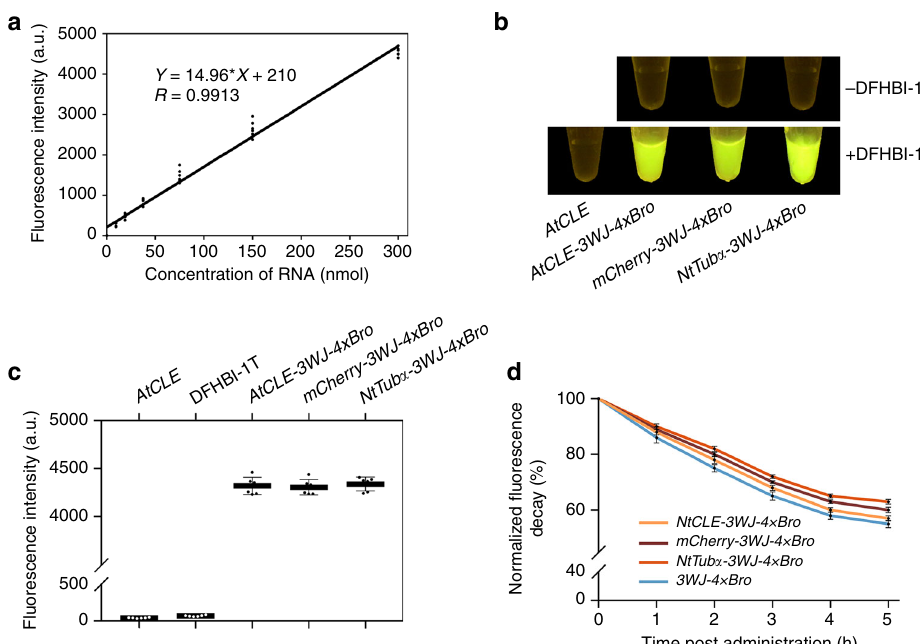
Fig. 3 Characteristics of 3WJ-4 × Bro after tagging various mRNAs in vitro. a Linear regression of fl uorescence intensity and mRNA content ( n = 6). b Representative image of 300 μ M 3WJ-4 × Bro-tagged mRNAs in vitro after incubation with 10 μ M DFHBI-1T. c Quanti fi cation of the fl uorescence of RNA – DFHBI-1T complexes in b using a fl uorescence spectrophotometer. Error bars, mean ± s.d. ( n = 6). d Comparison of the fl uorescence decay of 3WJ- 4 × Bro-tagged mRNAs within 5 h after DFHBI-1T administration. The fl uorescence decay was calculated after normalization of the remaining fl uorescence intensity to the respective initial fl uorescence intensity. Error bars, mean ± s.d. ( n = 6). All experiments were repeated three independent times. Source Data are provided as a Source Data fi